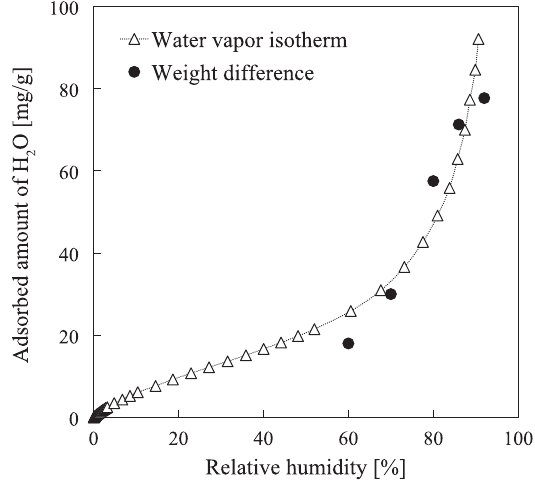
Fig. 4 Water vapor adsorption isotherm of Aerosil 200 with adsorbed amount of water measured by weight differ - ence before/after humidity